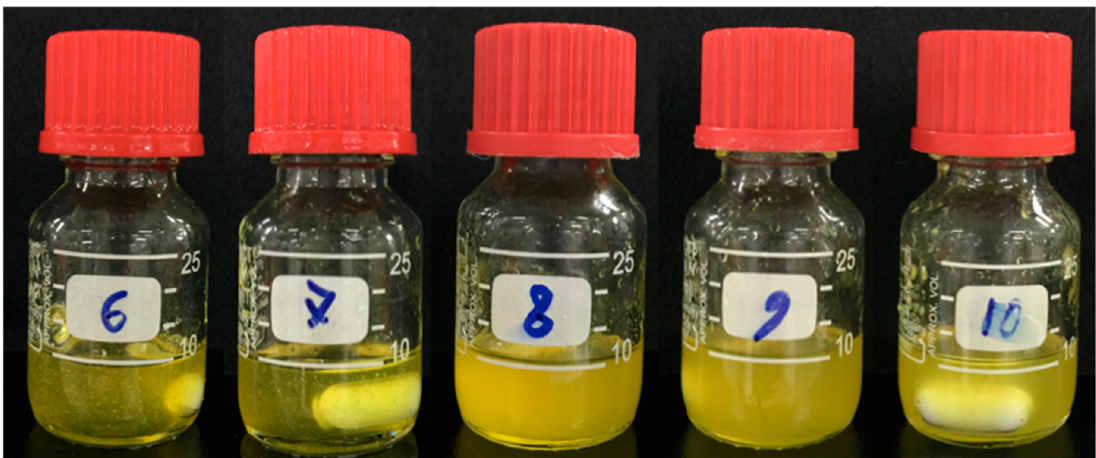
Figure 1. Cellulose solution dissolved in calcium thiocyanate as a function of contained water molecules (From left, in order: 6, 7, 8, 9, and 10 hydrates; Whatman No. 1 paper, 30 min at 120 °C).